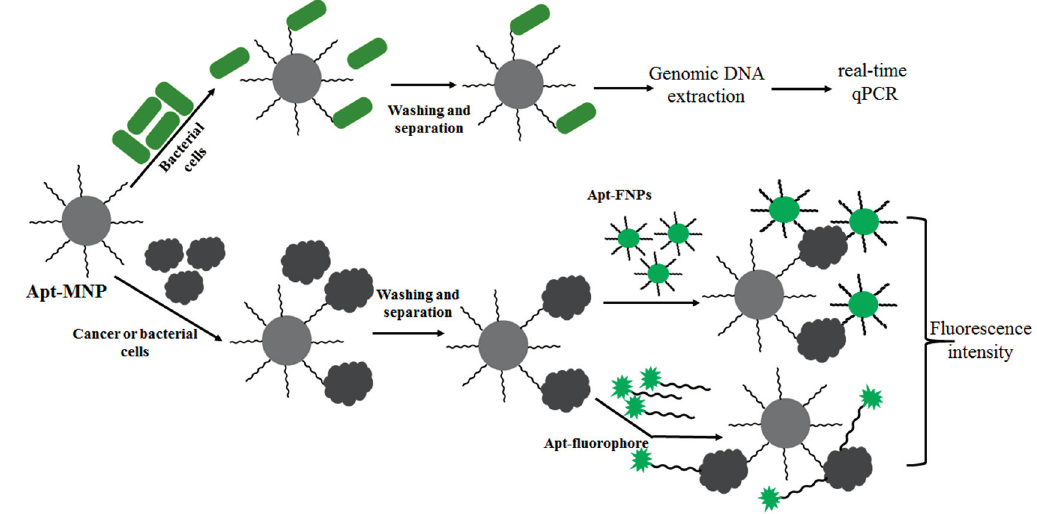
Figure 3. General strategies for cancer and bacterial cell detection using